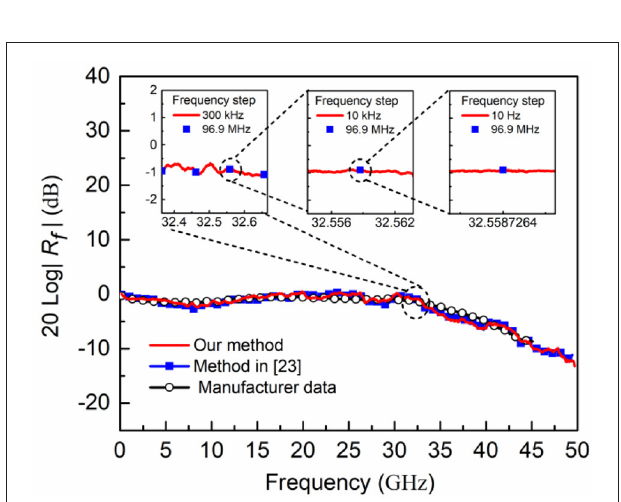
FIGURE 5 | Measured frequency response of PD with different methods and